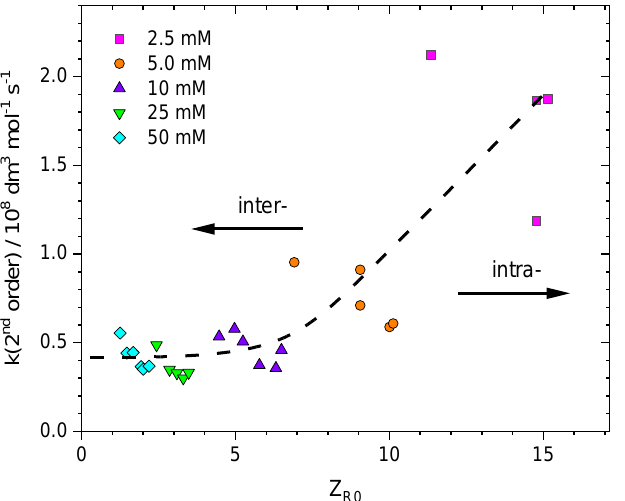
Figure 7. Kinetic analysis for decay of PAA radicals observed during pulse radiolysis of Ar-saturated aqueous solutions containing 2.5–50 mmol dm − 3 PAA, pH 2, dose per pulse 11–67 Gy. Second-order rate constant calculated for each experiment as a function of average initial number of radicals on a chain. Polymer concentrations, in mmol dm − 3 of monomer units, are given in the